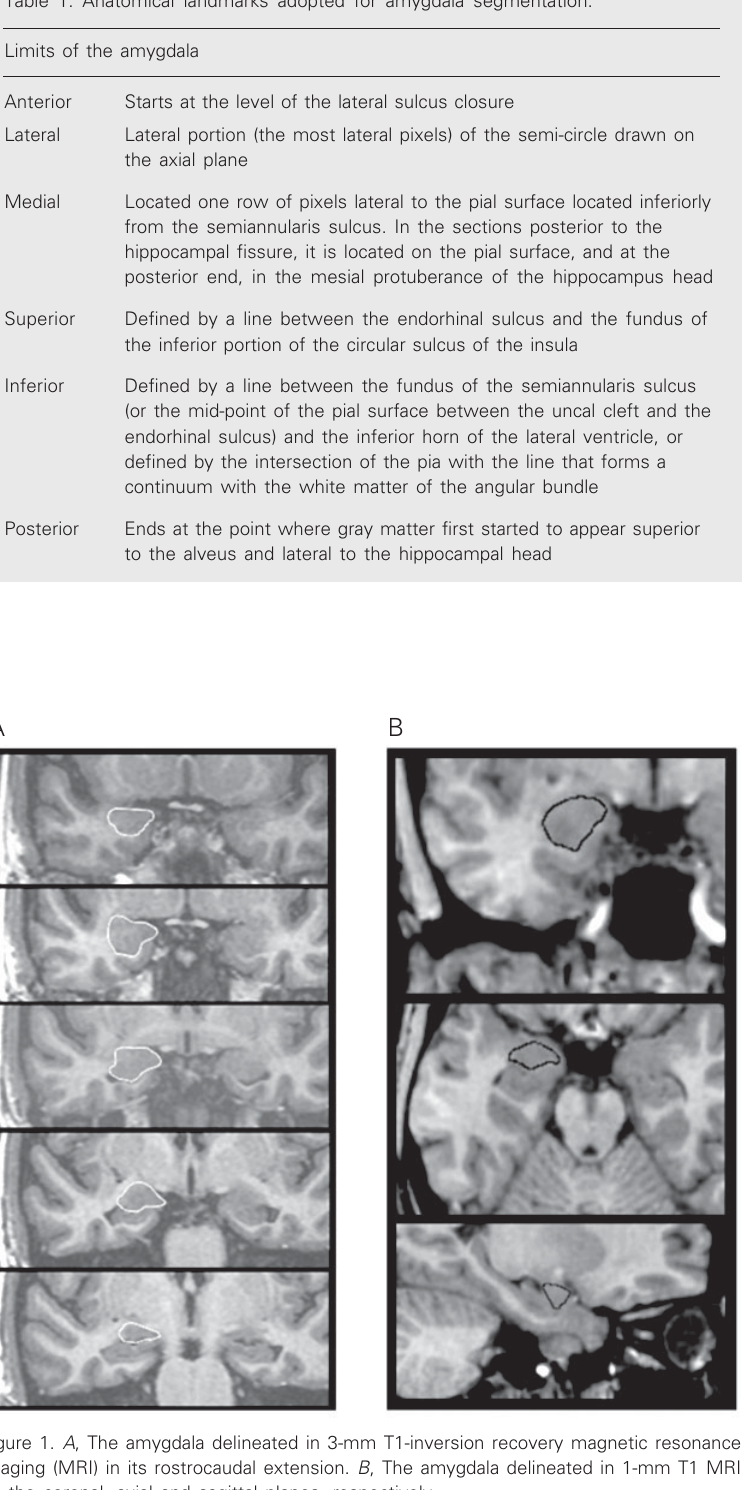
Table 1. Anatomical landmarks adopted for amygdala segmentation.